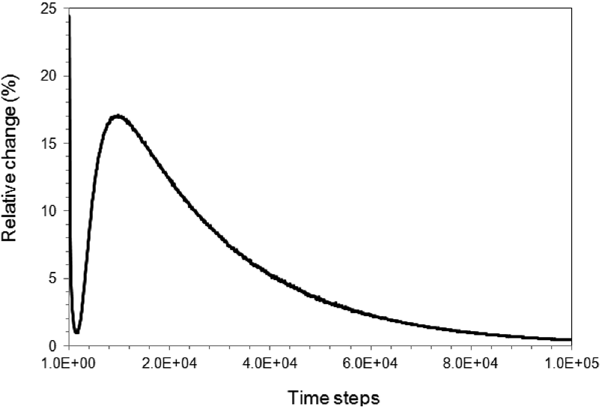
Figure 2. The convergence of relaxation method in the calculation of current density distribution.